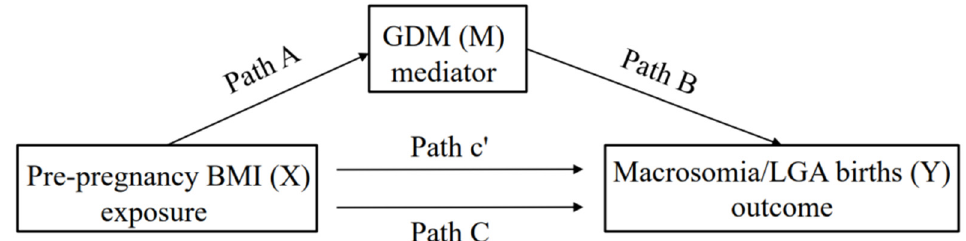
Figure 1. The total effect (Path C), direct effect (Path c’), and indirect effect (Path A and Path B) of the association among the exposure (X), outcome (Y), and mediator (M) are illustrated.